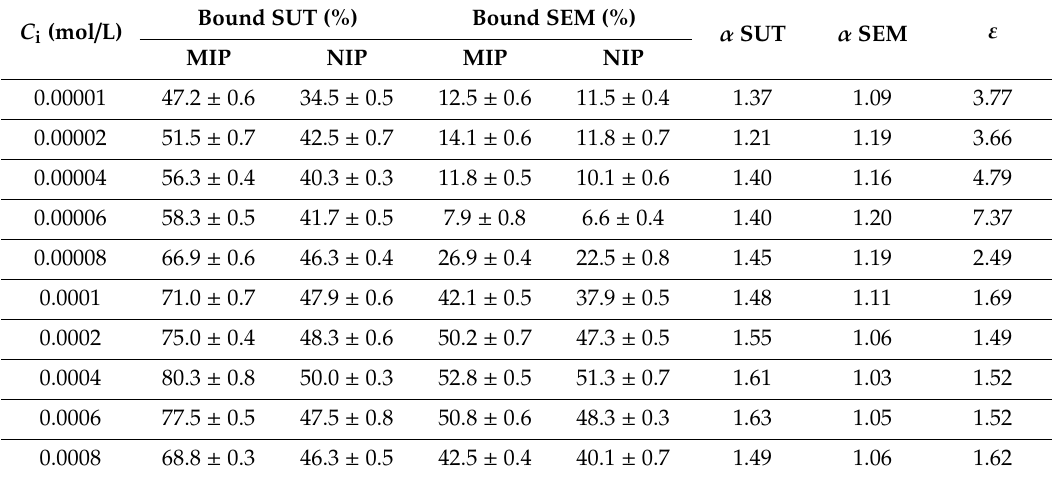
Table 2. Percentages of bound Sunitinib (SUT) and Semaxanib (SEM) by imprinted (MIP) and non-imprinted (NIP) particles and α and ε values for di ff erent C i . Data are shown as means ± S.D. Bound SUT (%) Bound SEM C i (mol / L)